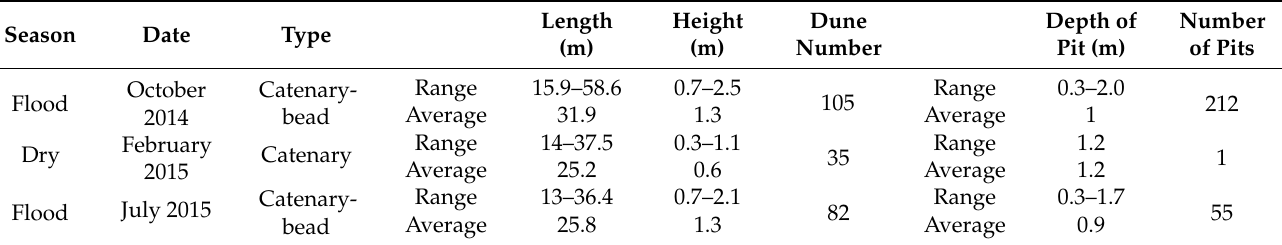
Table 1. Parameters of catenary-bead/catenary in the Yangtze